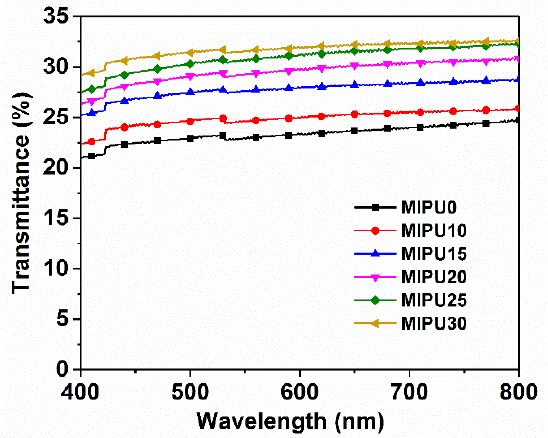
Figure 1. Photos of coatings after they were completely dried at room temperature.